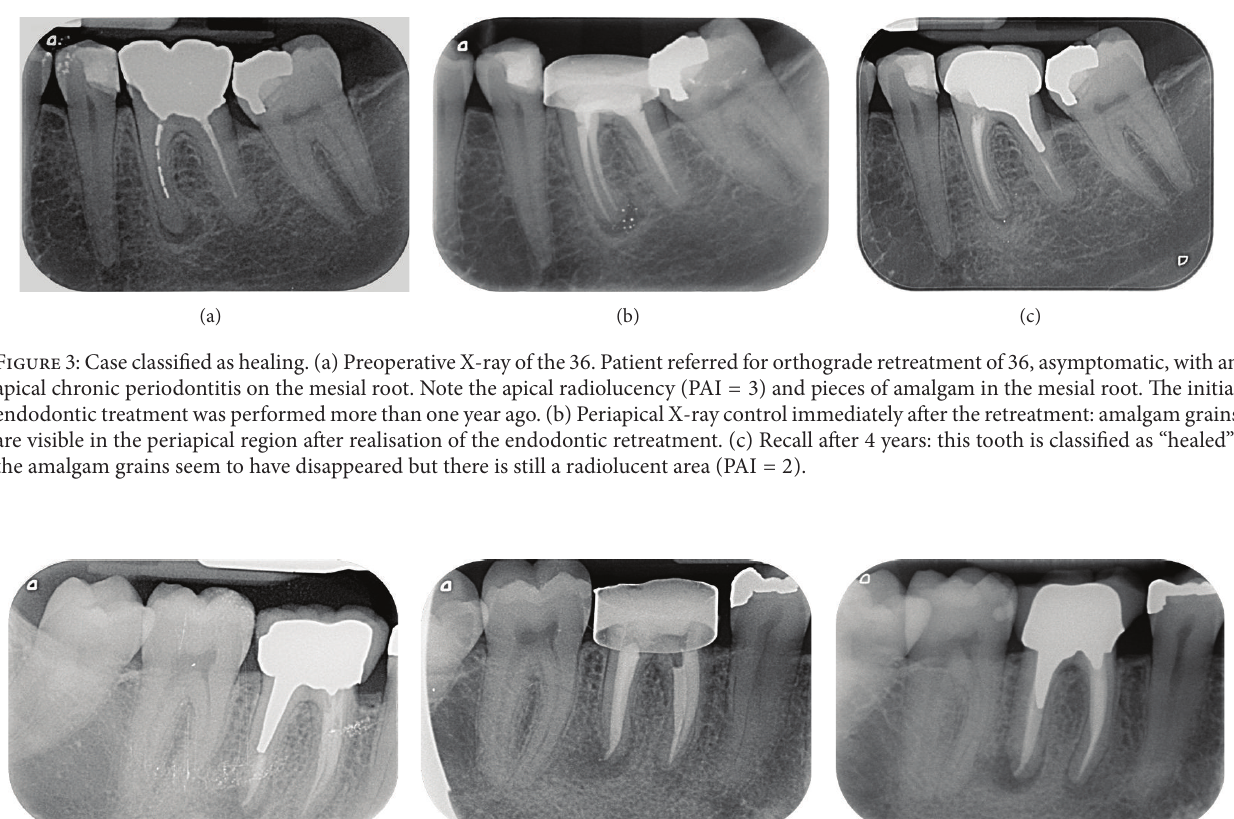
in the study: 23 teeth had received an initial endodontic treatment and 108 teeth an orthograde